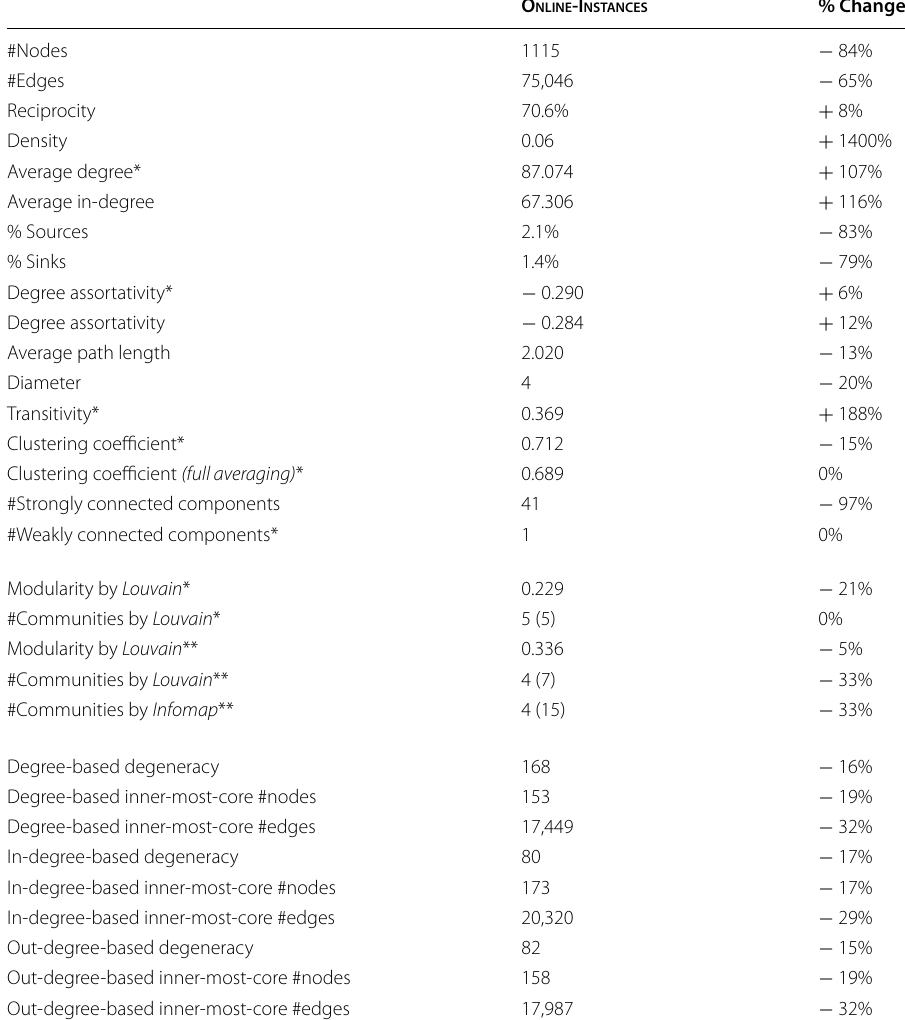
Table 8 Evolution of the I nstancEs network through a comparison of structural characteristics with the O nlInE -I nstancEs network. Percentage changes refer to the increase/decrease of a statistic from the value observed in the I nstancEs network. For the community statistics, percentage values refer to the number of communities containing at least ten